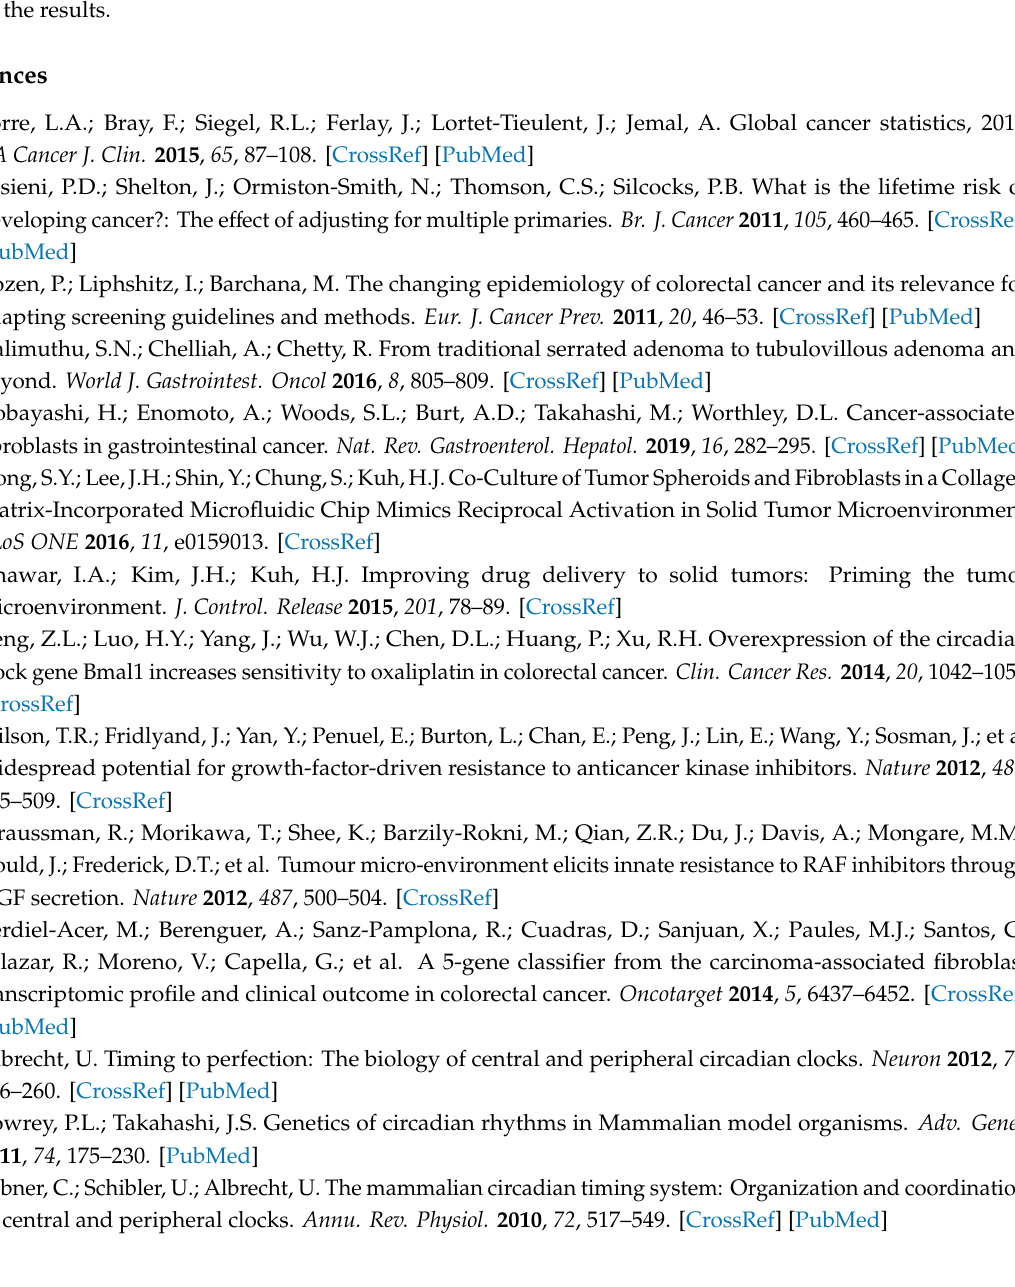
rhythms in HIF cell lines, Figure S5: Energy map for HCT116 cells showing the co-culture e ff ect caused by NFs or TAFs. Table S1: Harmonic regression analysis of rhythmicity for core-clock